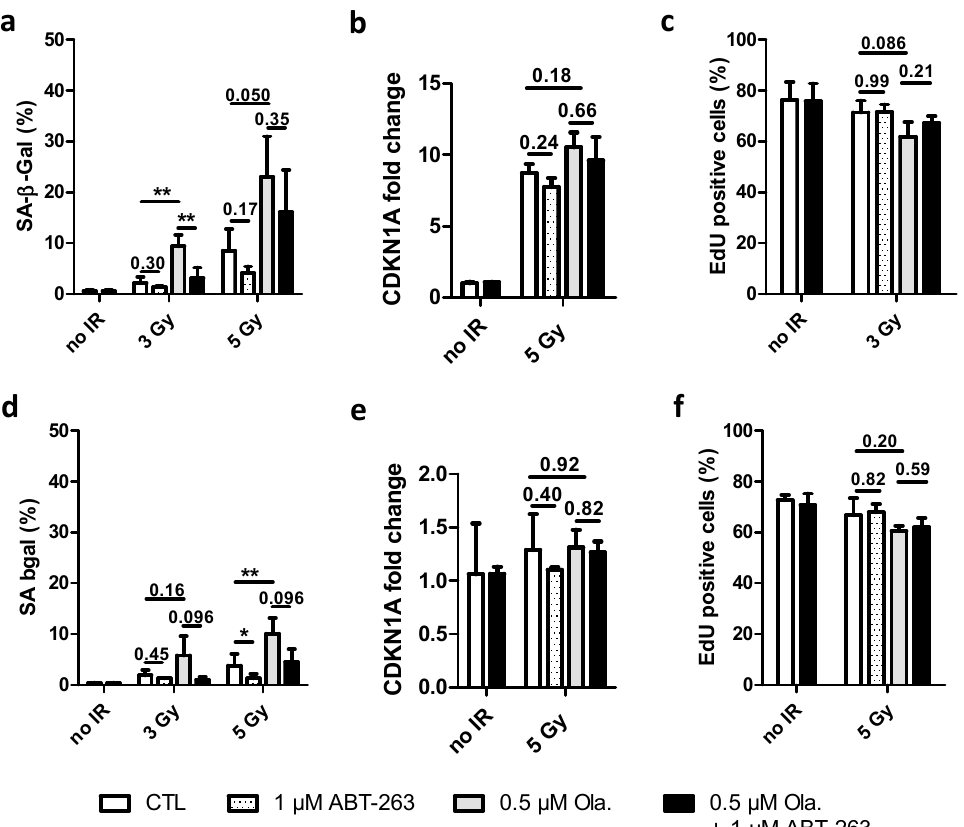
Figure 2. The effect of ABT-263 is reduced for cell lines with limited radio-induced senescence. HCT- 116 and KP4 cells were irradiated with 3 and 5 Gy X-rays with or without 0.5 µM of Olaparib. The medium was replaced 22 h after irradiation, and 1 µM of ABT-263 was added. ( a , d ) Quantification of SA- β -Gal positive cells 6 days after irradiation (( a ): HCT-116; ( d ): KP4). ( b , e ) CDKNA1 mRNA level 3 days after treatment (( b ): HCT-116; ( e ): KP4). ( c , f ) Quantification of EdU incorporation after a 10 µM 8 h pulse (( c ): HCT-116; ( f ): KP4). At least three independent experiments were performed, and data are presented as mean ± 1 SD. Unpaired t -tests were performed (*: p < 0.05; **: p < 0.01) for CTL vs. ABT, CTL vs. Ola and Ola vs. Ola + ABT.